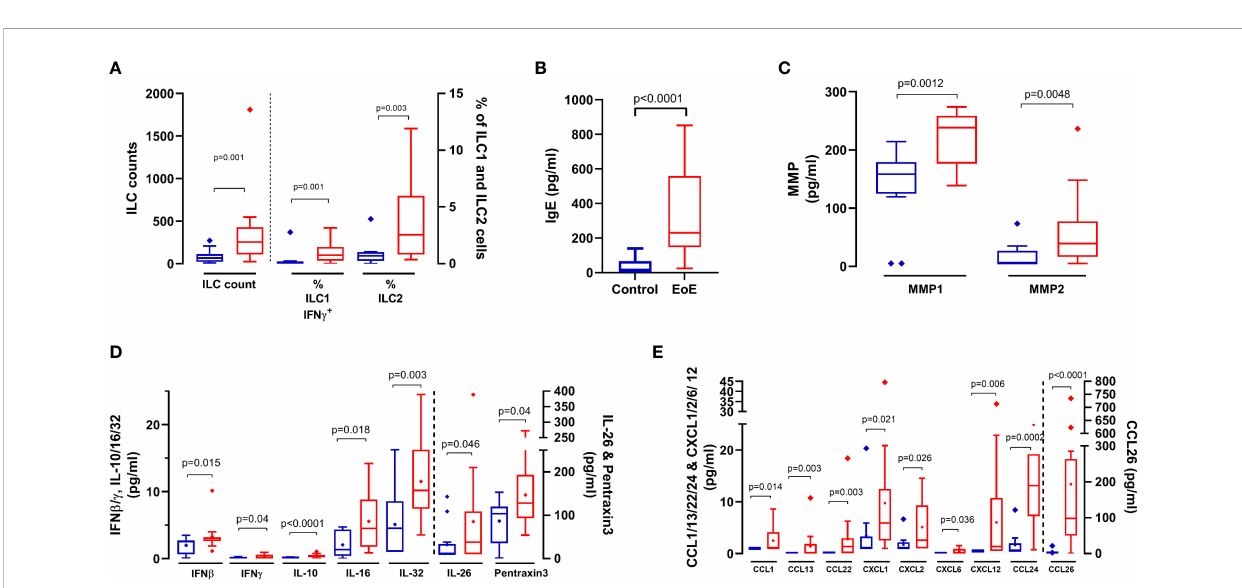
FIGURE 3 Cellular and soluble components in biopsies that signi fi cantly (p < 0.05) discriminate (VIP > 1) between EoE patients (red bars) and controls (blue bars): (A) ILC absolute counts, and frequencies of ILC1-IFN g + and ILC2. ILC1 and ILC2 were identi fi ed within live FSC low CD45 + singlet cells as lin - CD127 + populations, and then depending on intracellular Tbet and GATA3 expression, respectively. Activated ILC1 were further identi fi ed as IFN g + within ILC1 cells. Activated ILC1 and ILC2 are expressed as % of live FSC low CD45 + singlet cells. Total IgE (B) , Matrix Metalloprotease 1 and 2 (MMP1/2, (C) , cytokines (D) and chemokines (E) concentrations in supernatants obtained from biopsies. P values obtained through Mann-Whitney tests are